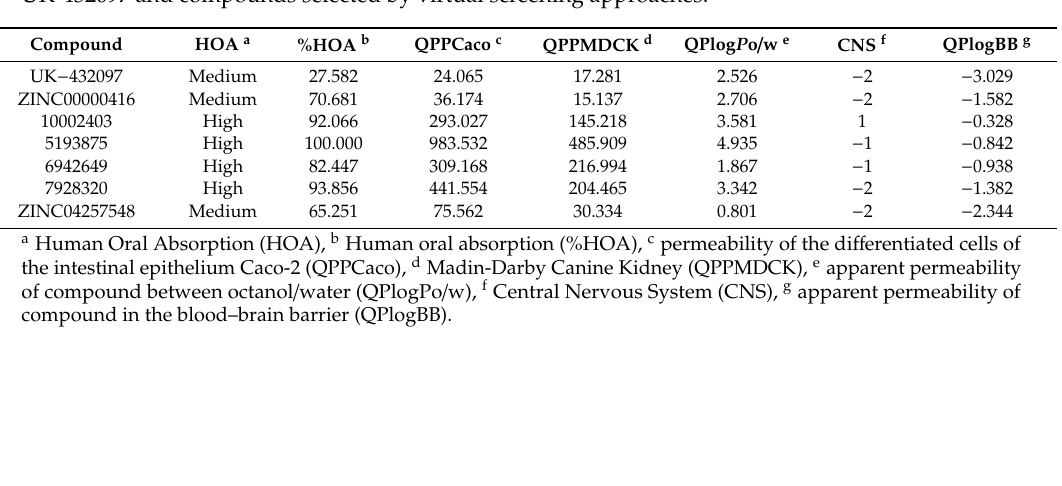
Table 7. Molecular properties calculated for evaluation of metabolism and pharmacokinetic profiles of UK-432097 and compounds selected by virtual screening approaches.